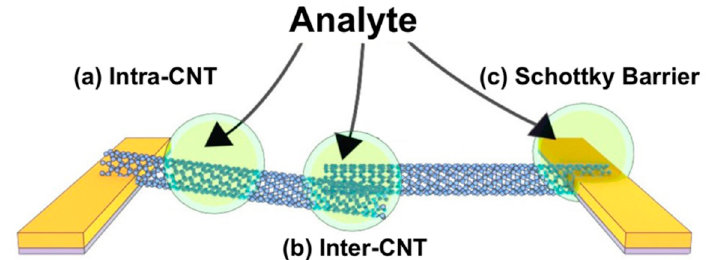
Figure 5. Schematic of possible sensitivity sites which affect the conductivity: ( a ) at the sidewall or along the length of the CNT itself, ( b ) interface between CNT-CNT (inter-CNT) and ( c ) at the interface between the metal electrodes and the CNT (Schottky barrier). Reprinted with permission from [15]. Copyright (2018) from American Chemical Society.